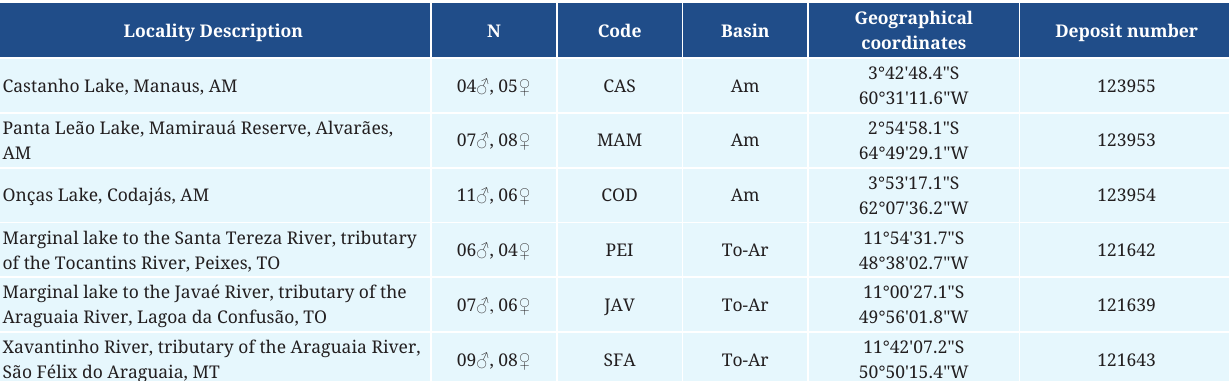
TABLE 1 | Localities, numbers, sex and voucher codes of Arapaima individuals analyzed in this study. Voucher specimens were deposited in the Museu de Zoologia da Universidade de São Paulo (MZUSP).